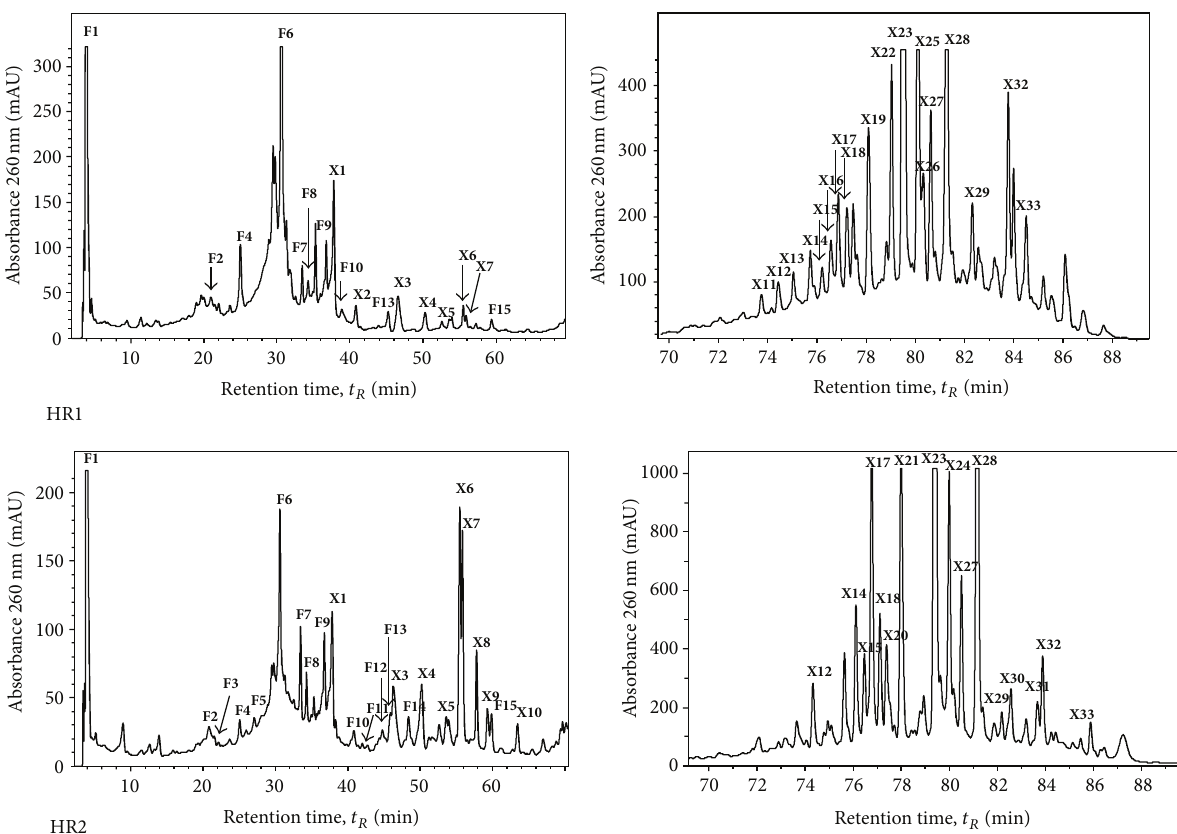
Figure 1: Chromatograms of Hypericum perforatum dark-grown (HR1) and photoperiod-exposed (HR2) hairy root culture extracts monitored at 260nm for detection of phenolic compounds. Compound symbols correspond to those indicated in Tables 1 and